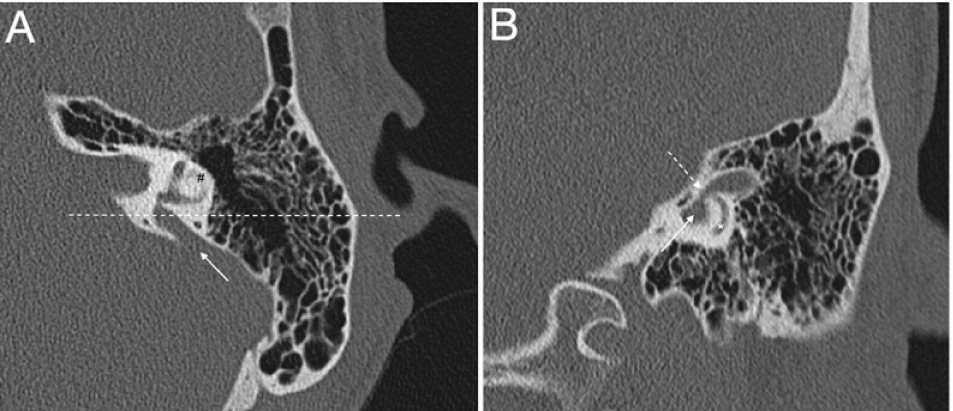
Figure 2. ( A , B ) Computed tomography of a left temporal bone of a 12-year-old female patient with bilateral enlarged vestibular aqueduct and congenital moderate (left ear) to profound (right ear) hearing loss. Section A: axial plane; arrow is the enlarged vestibular aqueduct; #, lateral semicircular canal; dotted line is the plane of section B. Section B: coronal plane; continuous arrow is the enlarged vestibular aqueduct; dotted arrow is the isthmus of the enlarged vestibular aqueduct; *, posterior semicircular canal. The patient harbors biallelic pathogenic variants (c.1301C > A; p.A434D and c.1730T > C; p.V577A) in the SLC26A4 gene, which were described in [43].